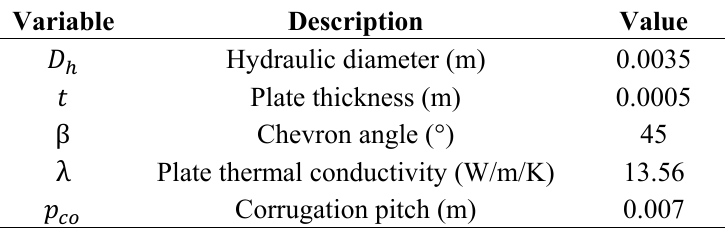
Table 4. Design parameters plate heat